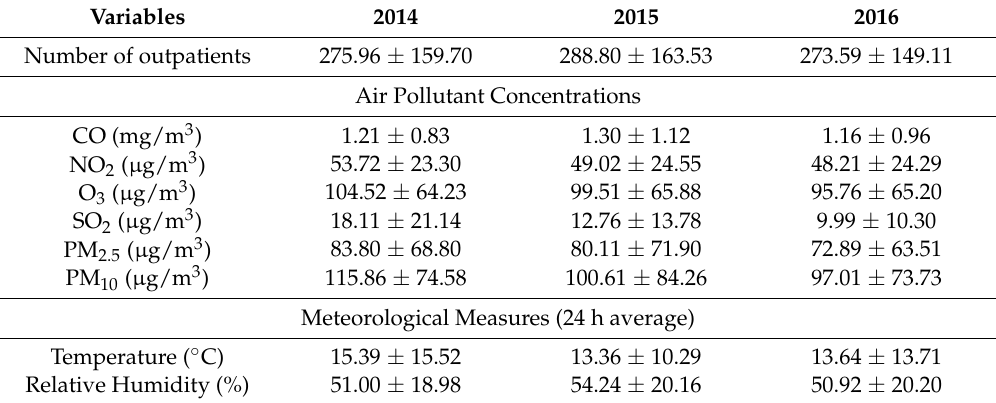
Table 1. Summary statistics of daily outpatients, air pollutant concentrations, and weather conditions,